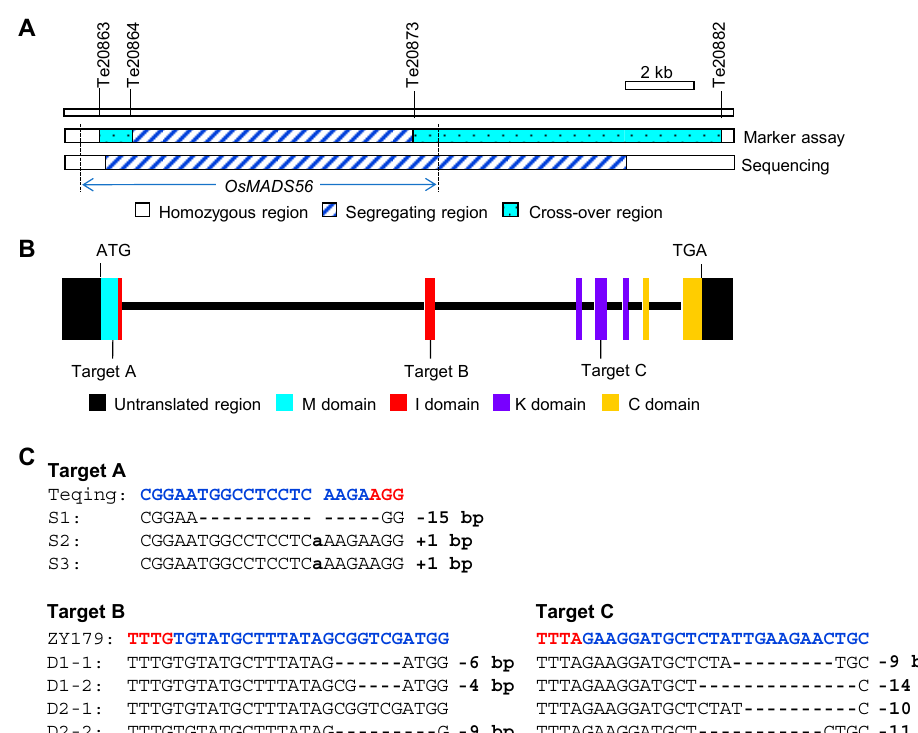
Figure 1. Variations of the mapping populations and OsMADS56 knock-out mutants. ( A ) Same segregating regions existed in the two mapping populations, OS3 and TE2. They were determined by marker assay and sequencing. ( B ) Three target sites of OsMADS56 . OsMADS56 contains four domains, i.e., MADS domain (M), intervening domain (I), keratin-like domain (K) and C-terminal domain (C). ( C ) Sequence variations of the mutations. S1, S2 and S3 were three homozygous mutants for target A in the Teqing background. D1-1, D1-2, D2-1 and D2-2 were four homozygous mutants for targets B and C in the ZY179 background. The target sequences and protospacer adjacent motif sites are shown in blue and red, respectively. Insertion is indicated by lowercase letter; deletion, by short dashes.